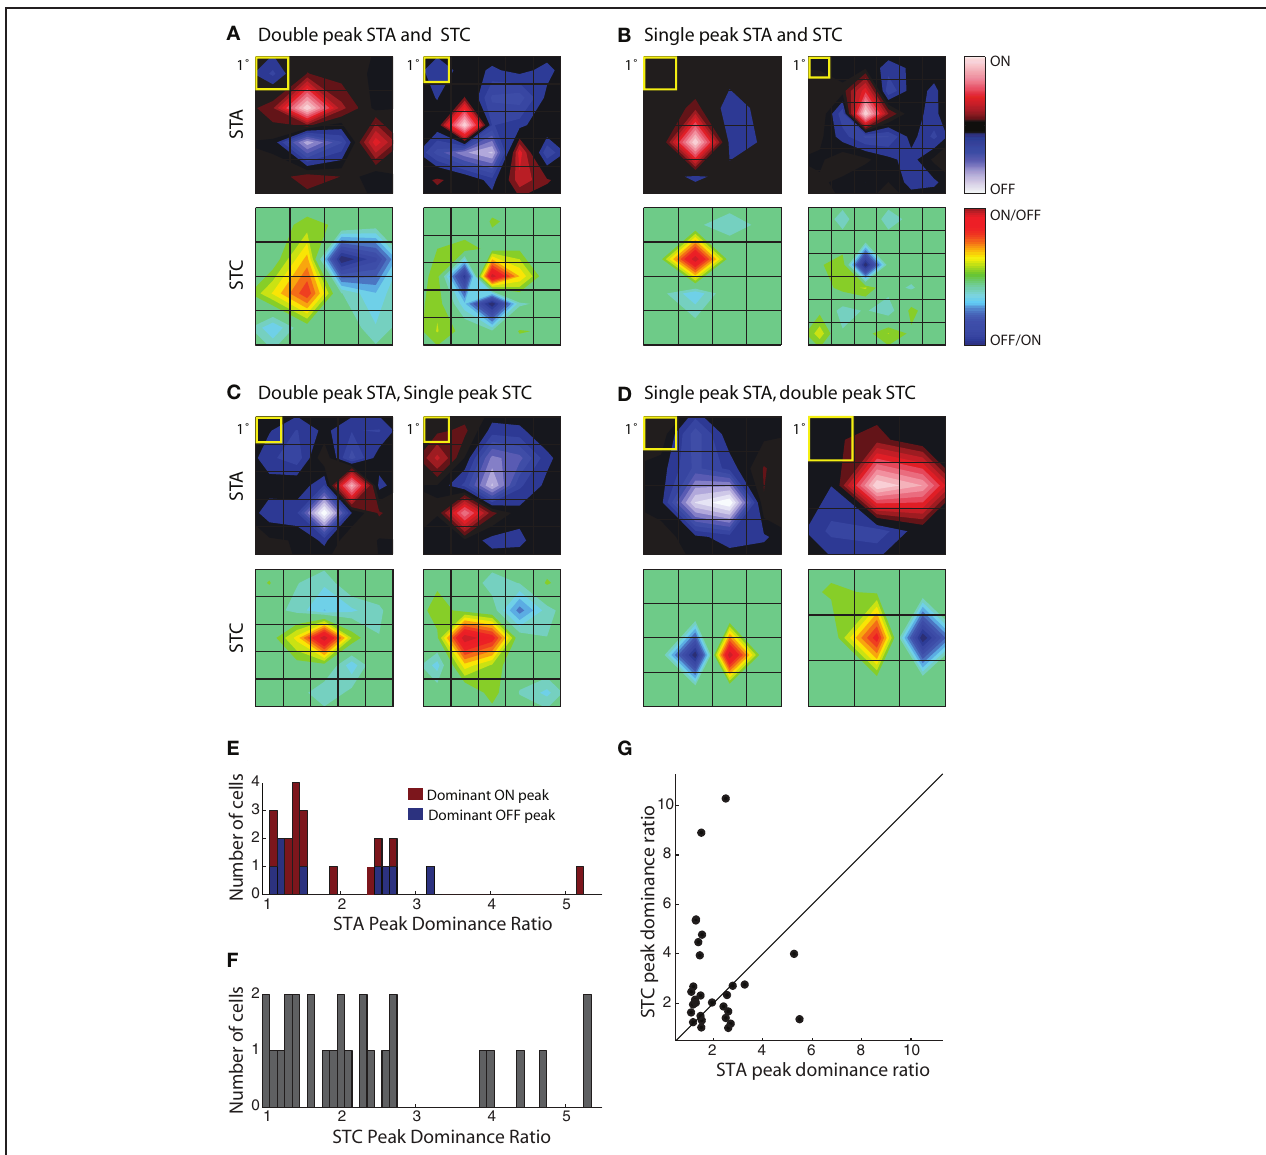
FIGURE 5 | Receptive field diversity in the PGN. (A–D ) Each panel illustrates spatial maps of subunits (STA, top and STC bottom) of the receptive field for two cells with similar receptive fields (yellow squares indicate 1 ◦ visual angle). The cells in the different panels are grouped according to the values of the peak dominance ratio for the STA and STC subunits. This ratio compares the relative strength of ON and OFF peaks, a value of one indicates subunits with two equally strong On and Off peaks and values greater than one indicate progressive differences between strengths of On or Off peaks. (A) Cells with double peaked STA and STC subunits; the peak dominance ratios for STAs, 1.49, 1.19 and STCs, 1.28, 1.24. The eccentricities were 10.6 ◦ (left) and 29.3 ◦ (right). (B) Cells whose STA and STC subunits were dominated by a single On or Off peak, peak dominance ratios for STAs, 5.2, 2.51 and STCs, 4, 10.28.